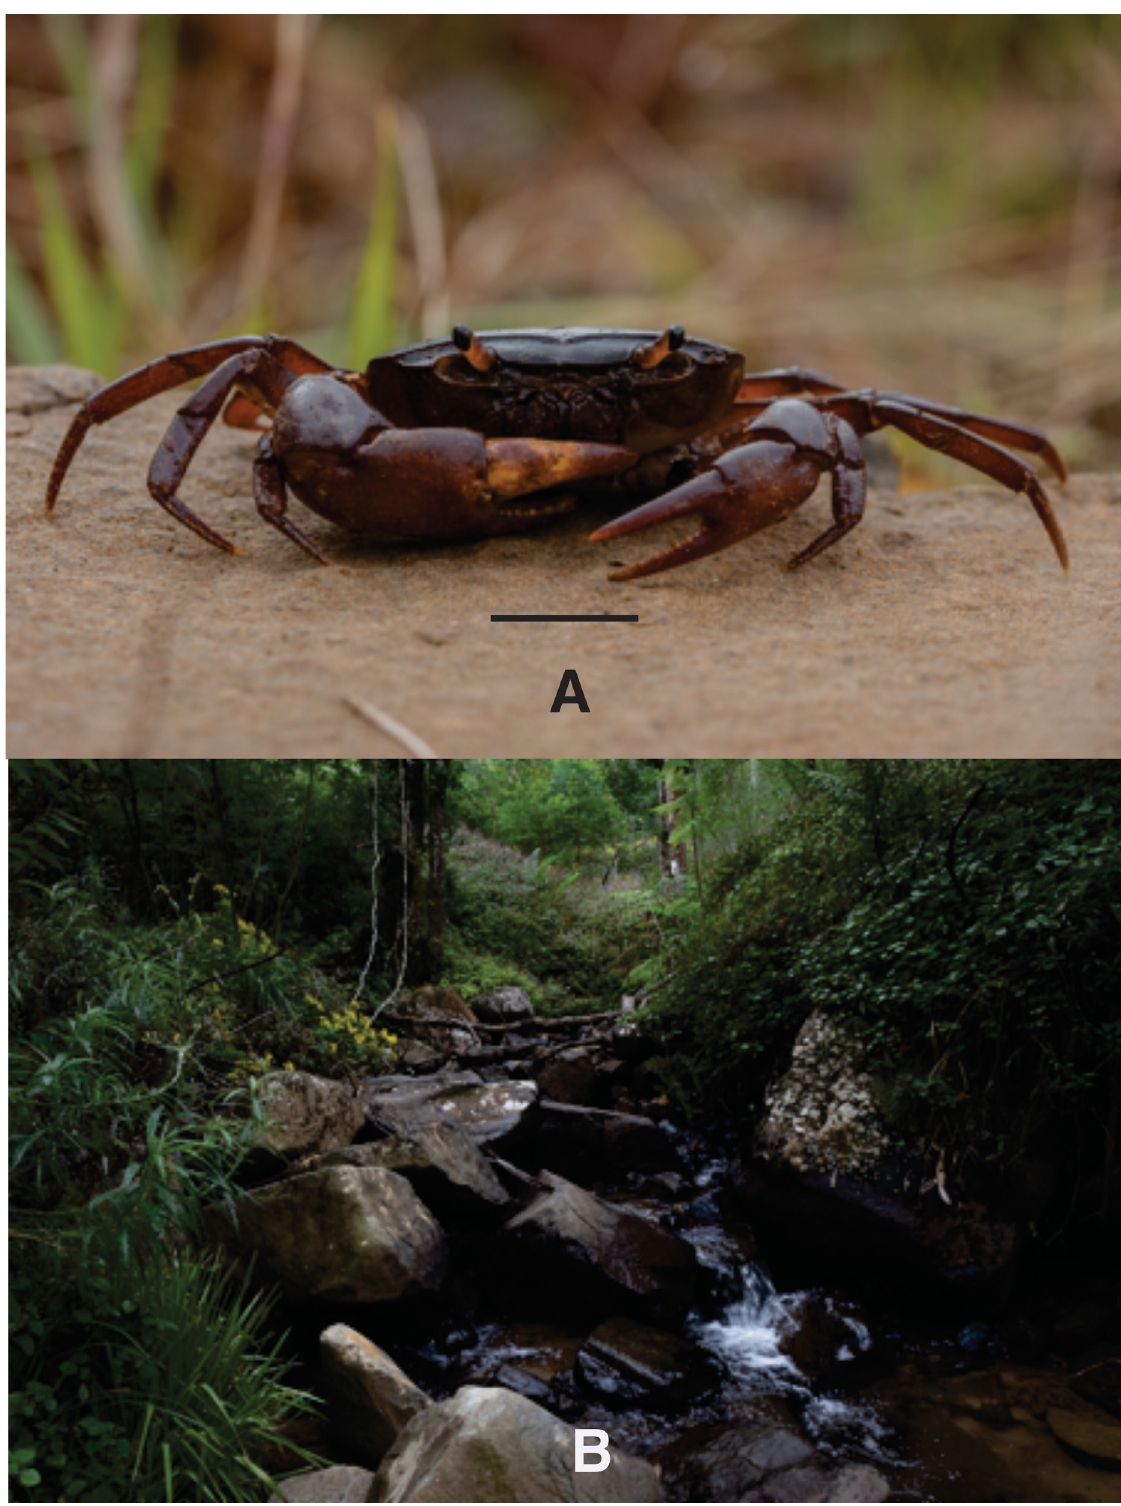
Fig. 10. A . Dorsal image of Potamonautes baziya sp. nov., when alive. Scale bar = 10 mm. B . Afrotropical forest stream habitat where P. baziya sp. nov. was collected at Baziya forest station in Eastern Cape Province, South